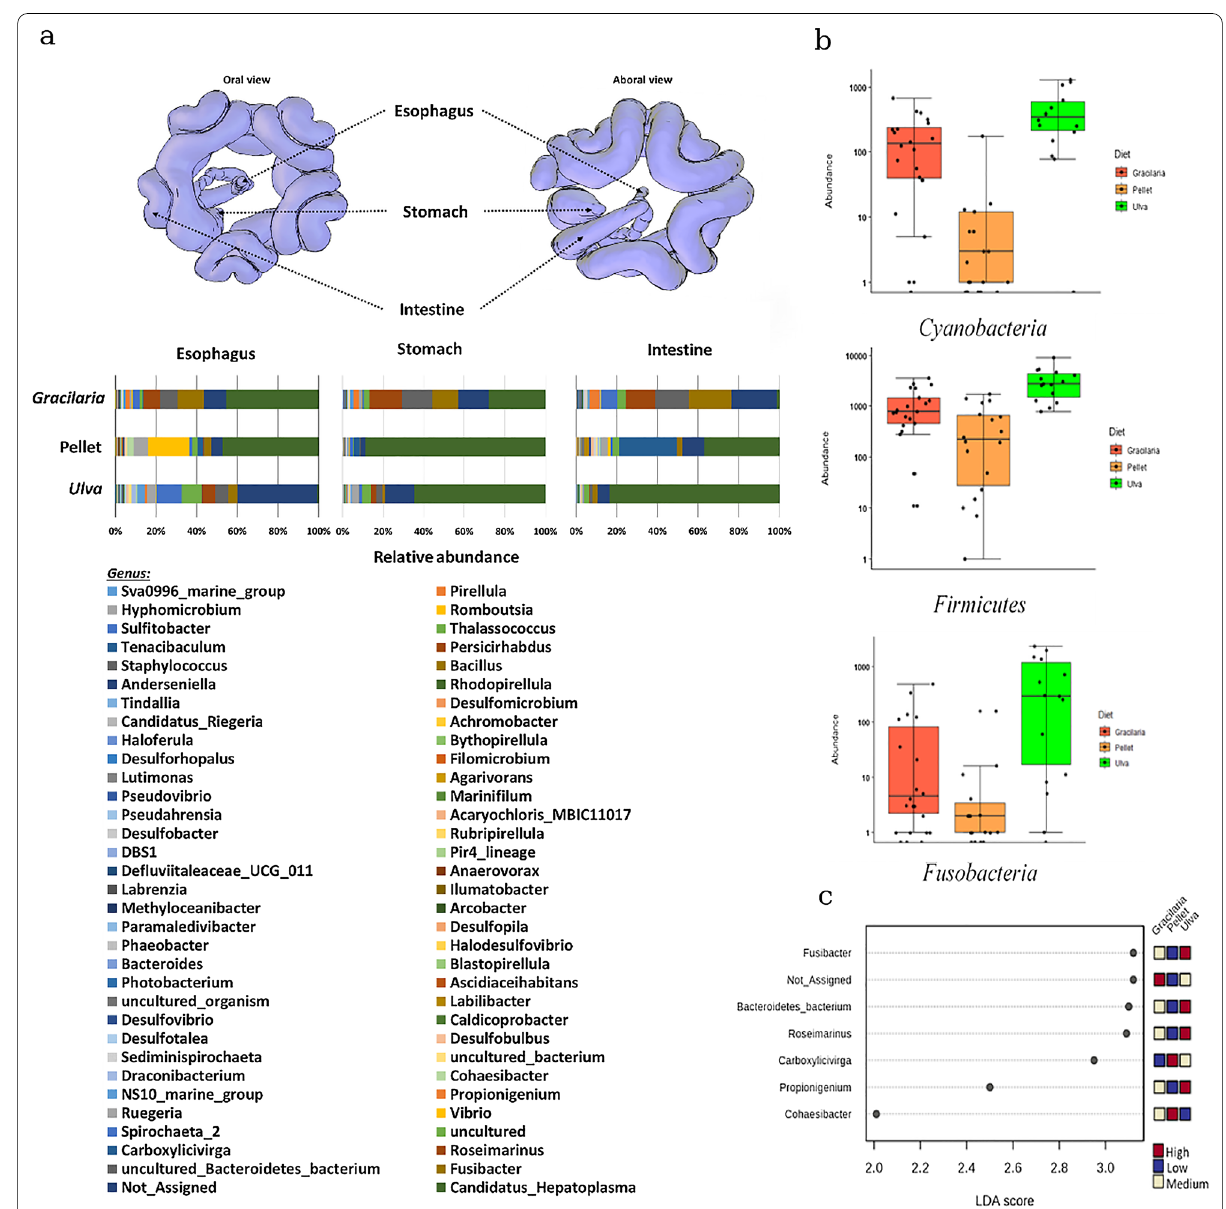
Fig. 2 T. gratilla elatensis GMA composition under different variables of diet and gut region. a Illustration of sea urchin digestive tract (performed using magnetic resonance imaging [49] and image illustrator at https:// www. nhm. ac. uk/ our‑ scien ce/ data/ echin oid‑ direc tory) followed by the relative abundance of T. gratilla elatensis gut microbes (Genera) in different gut regions and under each diet (n bacterial phyla with greatest differences in prevalence under a particular diet, middle line represents median, and whiskers are drawn from the 10th to 90th percentiles (n 54). c Gut bacterial genera identified as diet‑biomarkers in T. gratilla elatensis via Linear discriminant analysis (n =